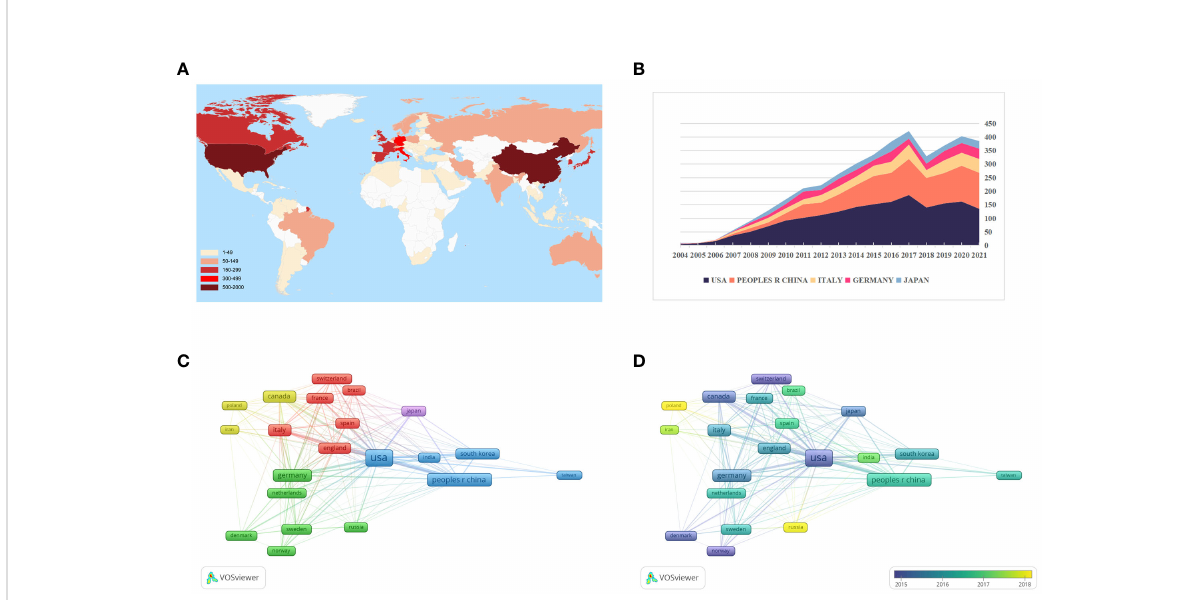
FIGURE 4 (A) The global distribution of different countries involved in glioma stem cells (GSCs) research based on their number of publications. The United State pays the most attention to GSCs, followed by China and Italy. (B) The growth trends of annual number of publications in the top 5 proli fi c countries during the period 2003-2021. The network visualization map (C) and overlay visualization map (D) of country co-authorship analysis generated by VOS viewer. Countries with the minimum number of 50 publications were assigned into fi ve